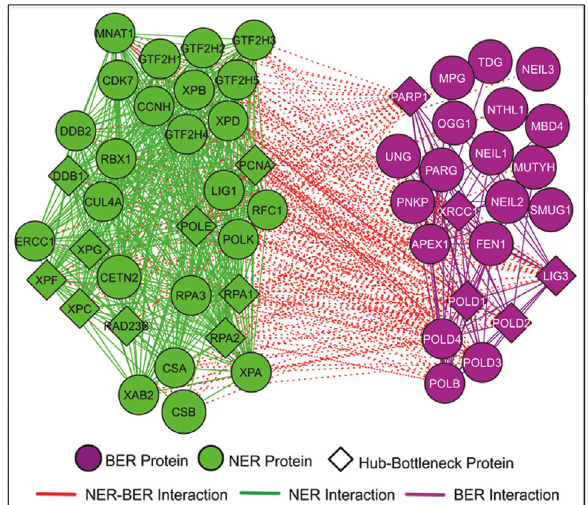
Figure 3 - PPI Network depicting the major players in both NER and BER. High connectivity between the two pathways can be observed in the network, which is composed of 55 proteins (32 from NER, 23 from BER) and734edges.TheparametersusedintheSTRINGsoftwareforthe Homo sapiens organism, were: (i) medium confidence score of 0.4; (ii) “expres- sion”, “databases”, “ neighborhood ” and “co-expression” interaction sources enabled; (iii) only queried proteins on the 1 st shell; and (iv) no in- teractions on the 2 nd shell. The centralities analyzed were node degree and betweenness, where 16 HB were